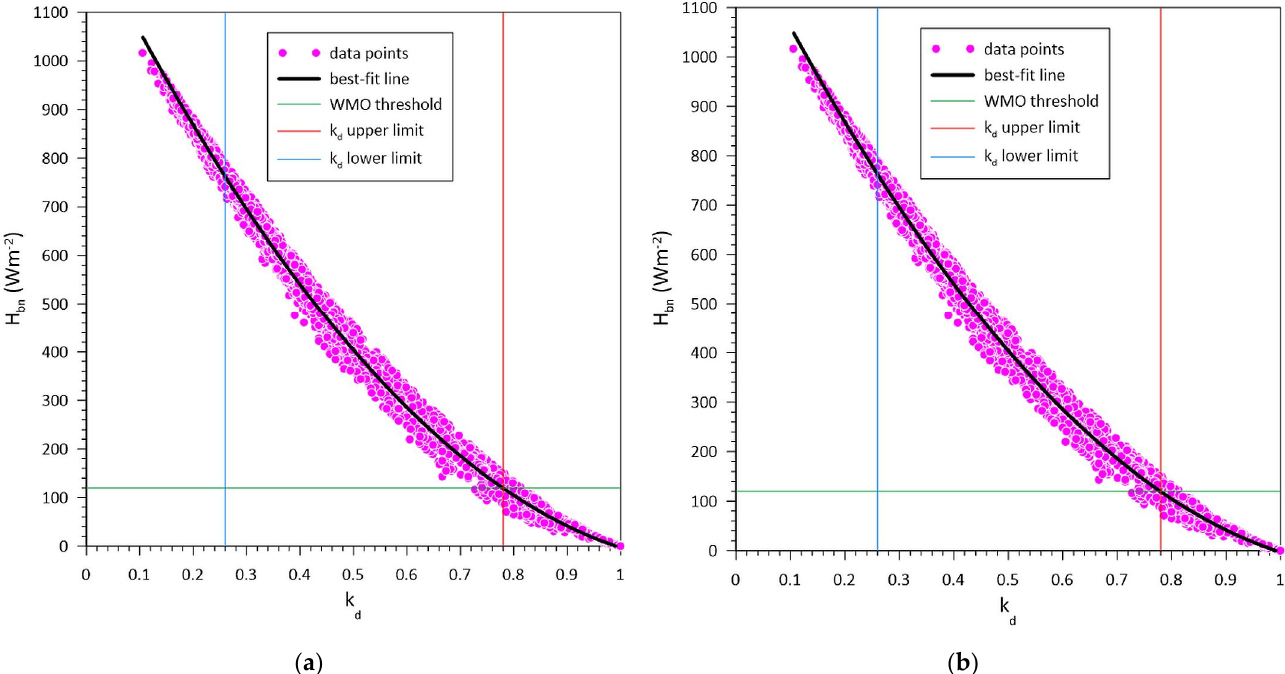
Figure 10. Determination of the k du (red line) and k dl (blue line) values for the ( a ) SON and ( b ) SOV sites. Table 2. Second-order polynomial expression for the function H bn vs. k d with R 2 , k du , and k dl values. All values have been rounded to the second decimal digit. The year in parenthesis in column 1 denotes the period of the downloaded solar radiation measurements from the BSRN sites. The criterion for the year selection was to be outside the PV-GIS TMY period of 2004–2015, if